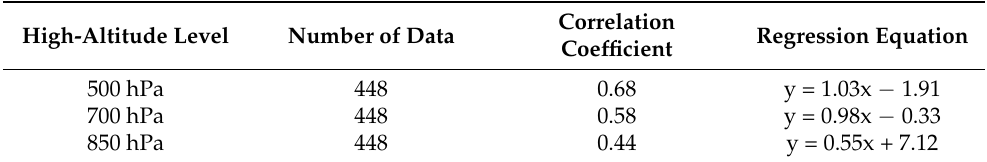
Table 3. Dew point correlation coefficients and linear regression equations for each level of 00Z for July and August of